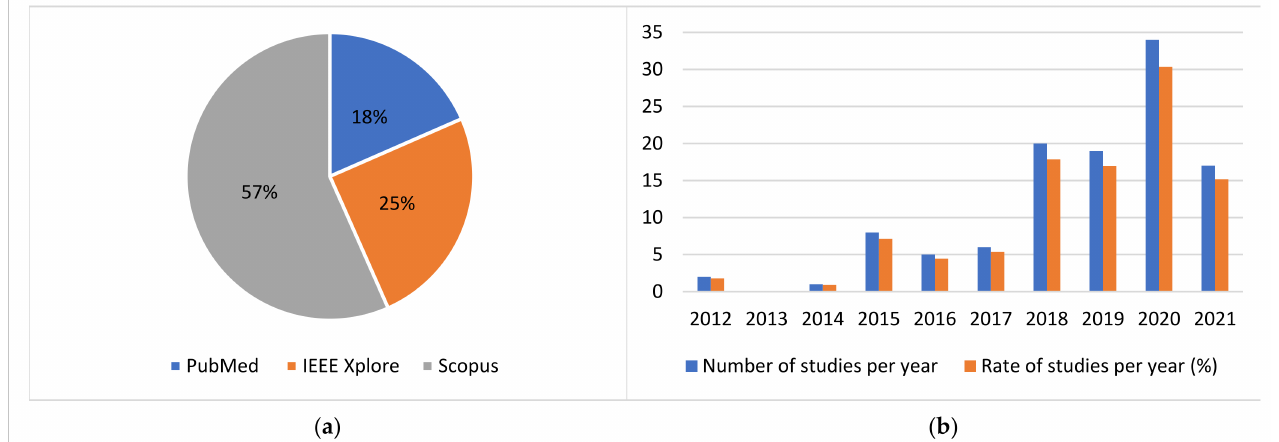
Figure 2. Distribution of ( a ) studies retrieved per academic citation database and ( b ) studies consid- ered per